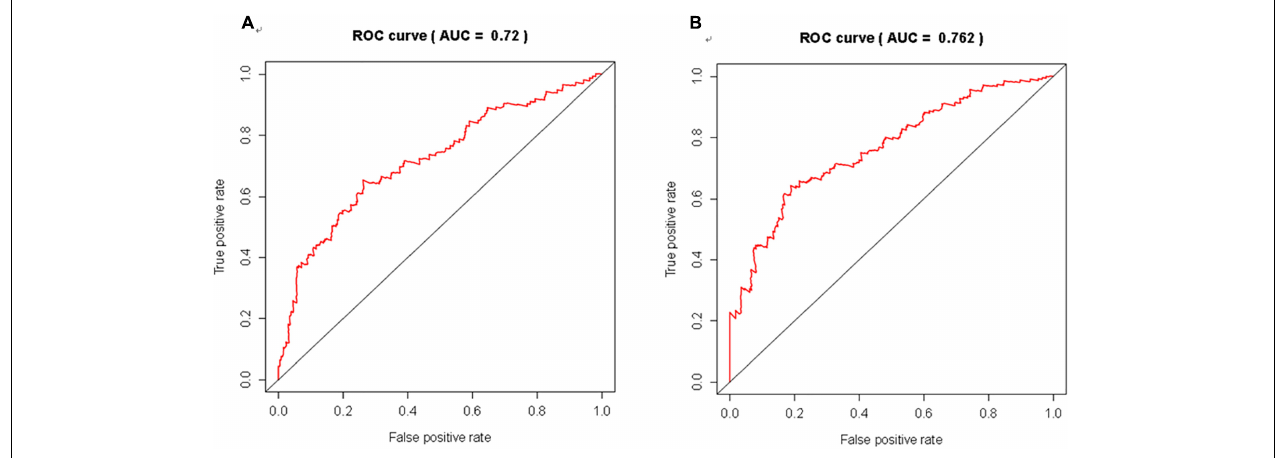
FIGURE 6 | The discriminatory ability of the evaluated multivariate DEGs in melanoma was accessed with ROC curve. (A) for 3 year; (B) for 5 years.